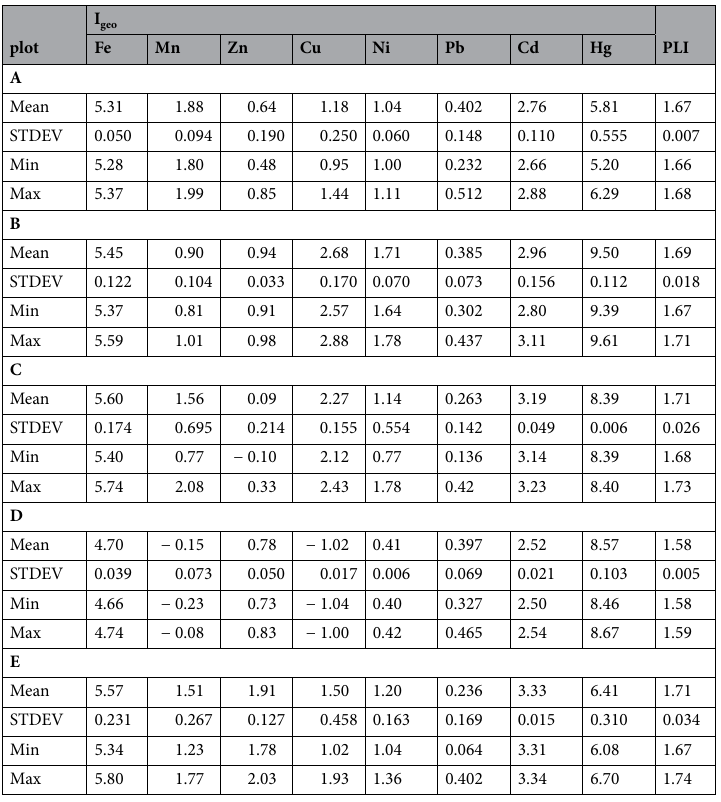
Table 6. Geo-accumulation index (I geo ), Pollution load index (PLI).